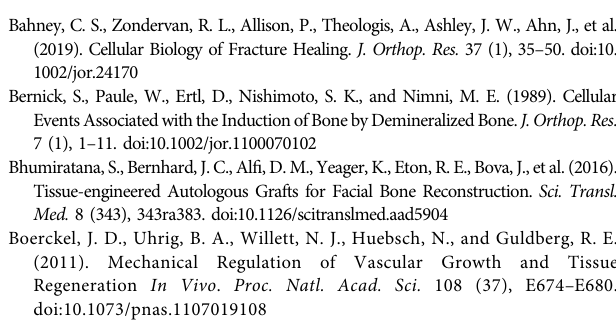
Supplementary Figure 1 | Control gels showing species speci fi city of rodent β - actin (R β -actin), human osteocalcin (HOC), and rodent osteocalcin (ROC). Supplementary Figure 2 | First generation of bone grafts used to develop the fabrication strategy. Left) Cross-sectional gross view of a fabricated sample graft showing the printed core and surrounding vascularized shell. Right) Maximum intensity projection of stitched confocal image stacks of such a graft partway through culturing showing DBM particles (green auto fl uorescence) and human neovasculature. SupplementaryFigure3| ArawmicroCTimagesetofmineralizationingraft687at 8 weeks of implantation used in mineralization assessments during implantation. Supplementary Figure 4 | 3D printed model of a patient-speci fi c defect. (A) stl. fi le derived from a CT scan of a patient ’ s mandible with a segmental defect within the mandiblebody (arrow). (B) Subtraction ofdefect geometry from themandible.stl fi le was used to create a space fi lling, printable graft fi tted to the defect geometry (the tooth line is facing down) in the TSIM ® modeling software. (C) BioBone “ ink ” described in this study was used to print the segmental defect. The printed core is shown without the surrounding tissue shell, no cells were used in this proof-of- concept print. (D – F) Fitting of the printed core graft to the defect using a 3D printed, plastic, scaled-down model of the patient ’ s mandible. Supplementary Video 1 | Volume rendered bone graft, from confocal images, showing the spatial relationship between DBM particles (green) and the growing neovasculature